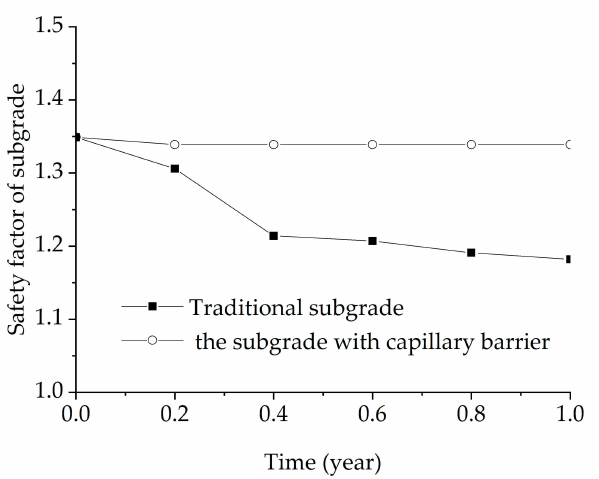
Figure 10. Comparison of the safety factor in the different